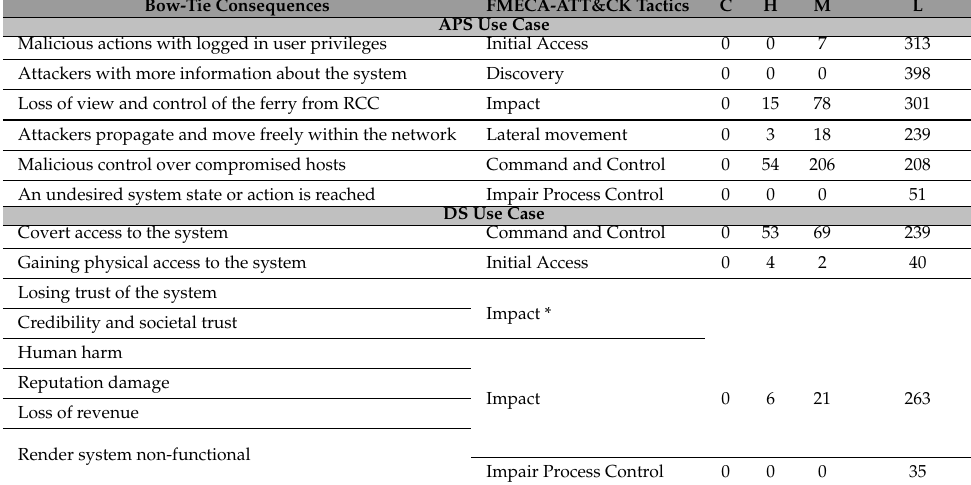
Table 4. The relations between the top consequences/objectives identified through Bow-Tie and